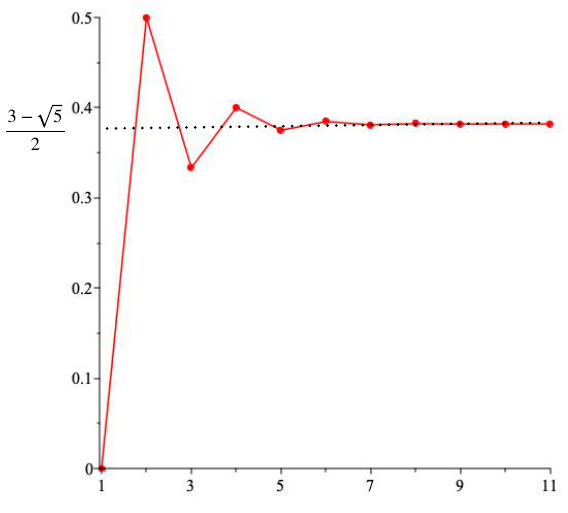
−(cid:112) 5 given by Eq. 2